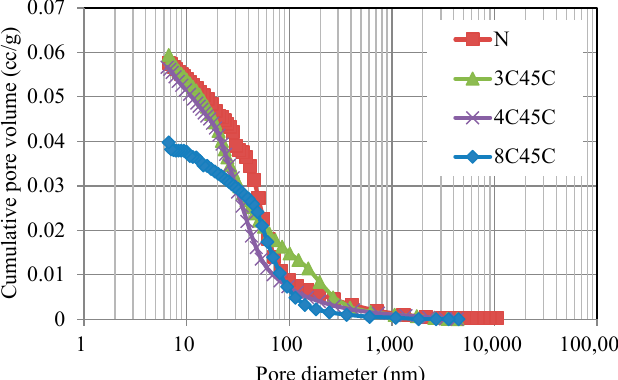
Figure 3. Cumulative pore volume of BFS-blended mortar with different Blaine fineness values for BFS by means of mercury intrusion porosimetry.